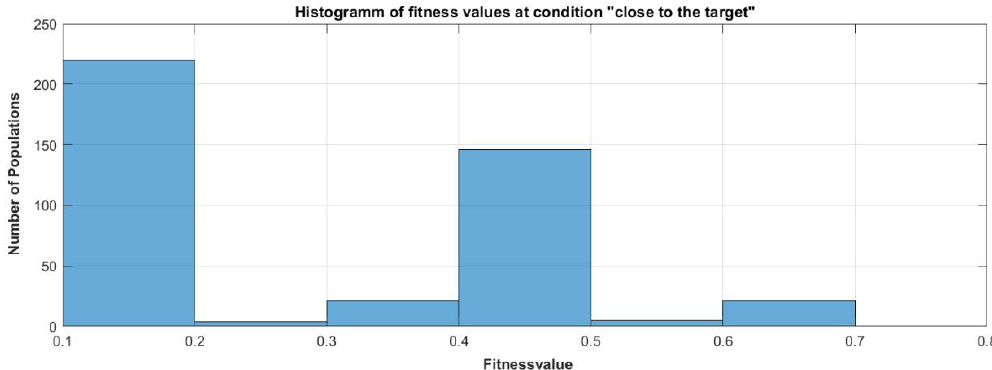
cluster with a little number of populations exist at fitness values of approximately 0.3 and 0.7.